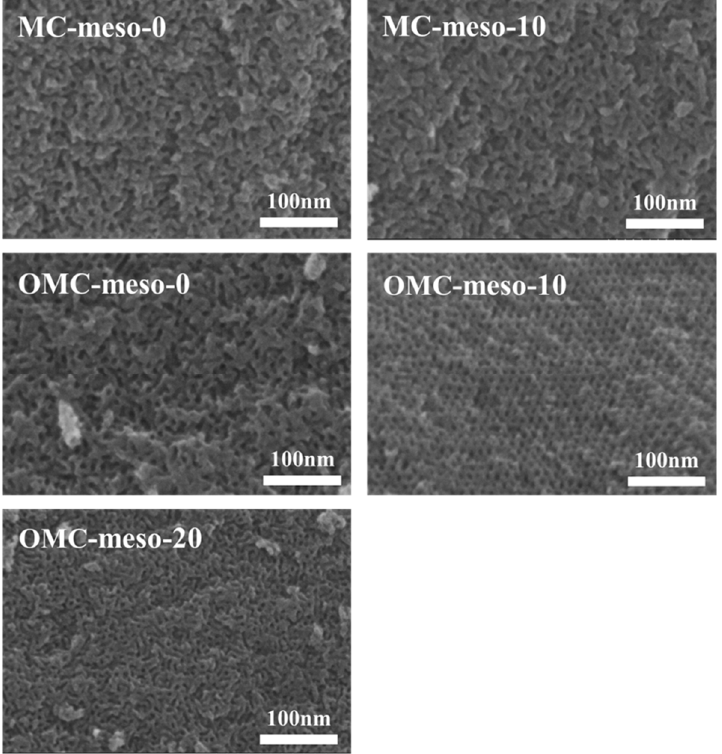
Figure 3. FE-SEM images of MCs and OMCs prepared with different amounts of mesophase pitch.